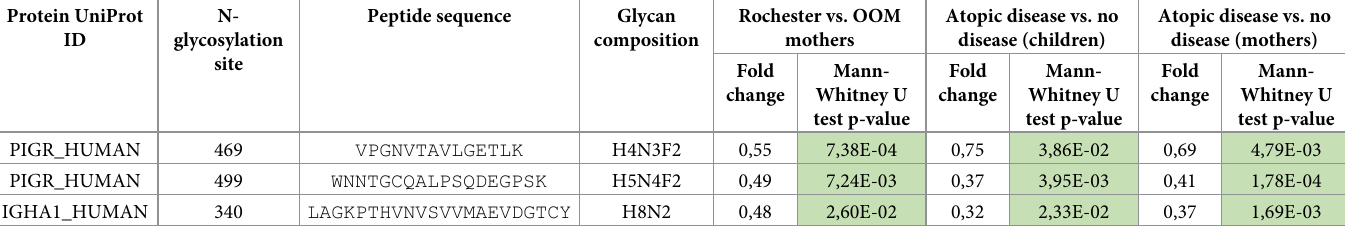
Table 4. The three N-glycopeptides identified that had significantly different abundances in all three comparisons (according to community, presence of atopic dis- ease in children, and presence of atopic disease in mothers) in this study. Protein UniProt N- Peptide sequence Glycan ID glycosylation site